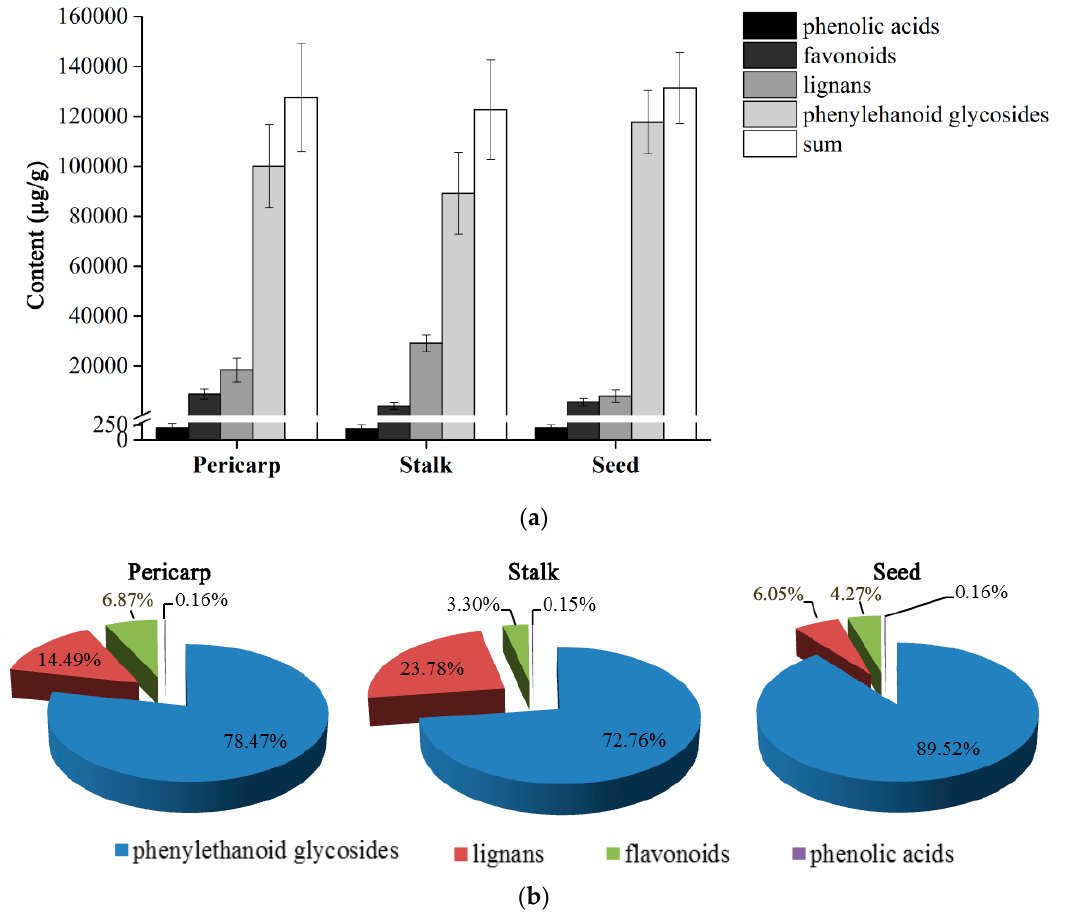
Figure 1. Content ( a ) and content ratio ( b ) of four structural types of analytes in different segments of Forsythiae Fructus. Forsythiae